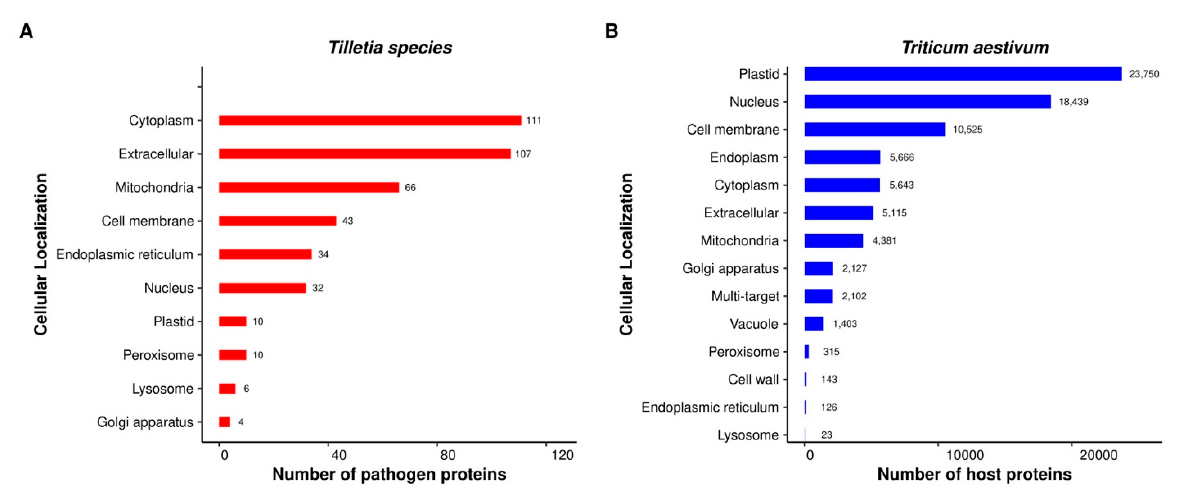
Figure 8. Subcellular localization of the pathogen proteins ( A ) and host proteins ( B ) involved in the common subnetwork.